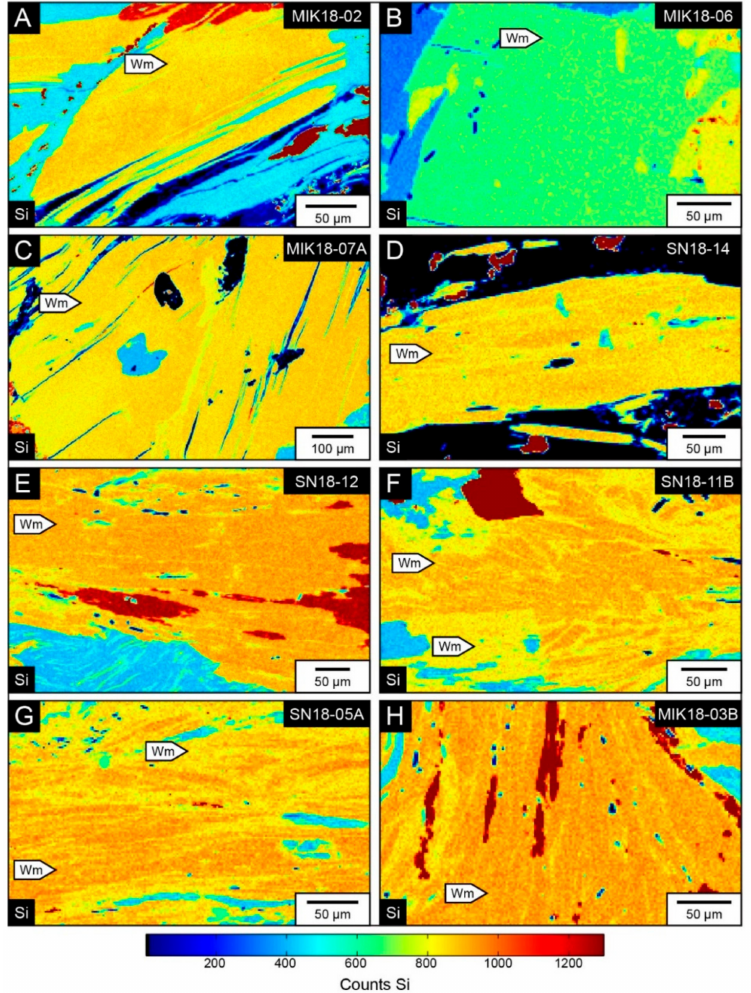
Figure 3. Electron microprobe (WDS) chemical maps of Si for samples of the upper ( A – D ) and Lower Unit rocks ( E – H ). ( A , B ) White mica grains from the foliated blueschists. ( C ) A bundle of white mica from the massive blueschist. ( D ) White mica from the schistose marble. ( E ) White mica that defines the foliation of the phyllite proximal to the bounding thrust of the two units. ( F , G ) White mica grains that define the foliations of phyllitic rocks distal from the bounding thrust. ( H ) White mica within well-foliated micaceous clasts in the breccia from the Lower Unit. All maps are presented according to the lower scale of Si counts. Abbreviations: Wm, white